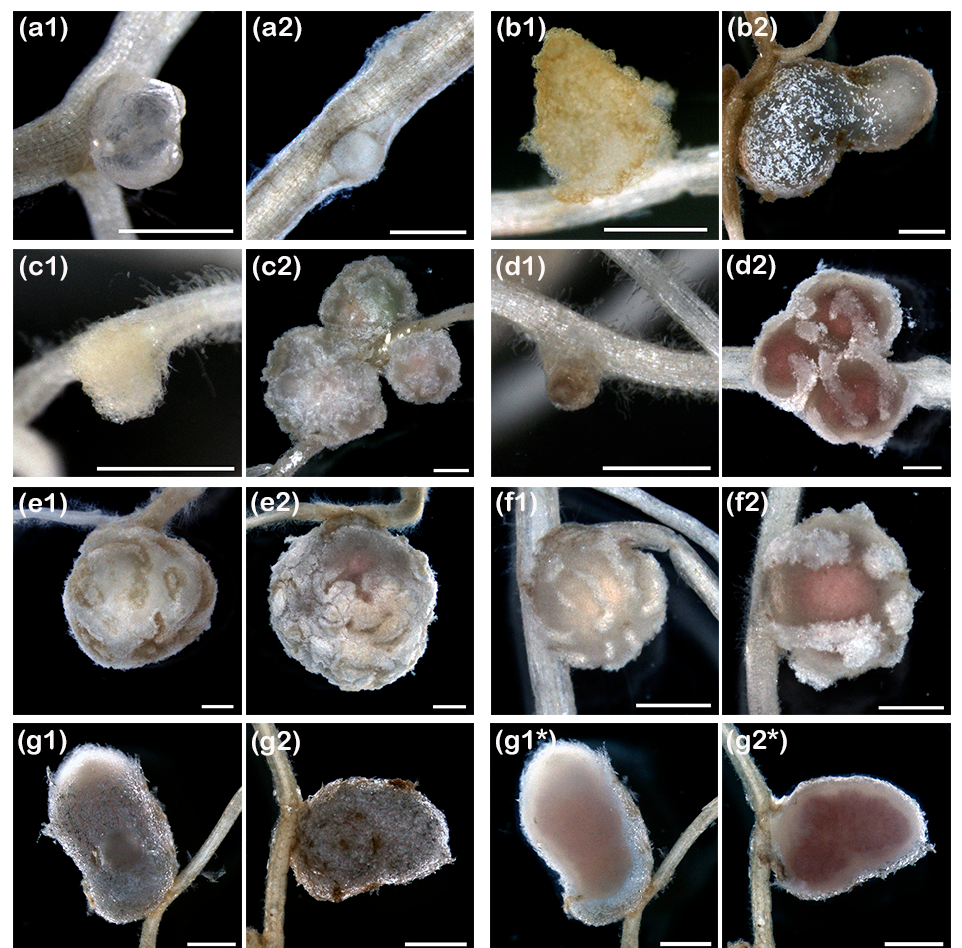
Figure 2. Representative examples of pseudo- or mature-like nodule structures formed by ANU265::pMiniSym2 ( 1 ) or NGR234 ( 2 ) on roots of, respectively: ( a ), Stylosanthes guianensis cv. Schofield; ( b ), Cajanus cajan cv. Lab22; ( c ), Tephrosia vogelii ; ( d ), Vigna radiata cv. King; ( e ), Lablab purpureus ; ( f ), Vigna unguiculata cv. Blackeye; and ( g ), Leucaena leucocephala . In ( g1* ) and ( g2* ), corresponding sections of the L. leucocephala nodules shown in ( g1 ) and ( g2 ), respectively. Scale bars in ( a1 ), ( a2 ), ( b1 ) and ( c1 ) are 0.5 mm. All other scale bars are 1 mm.